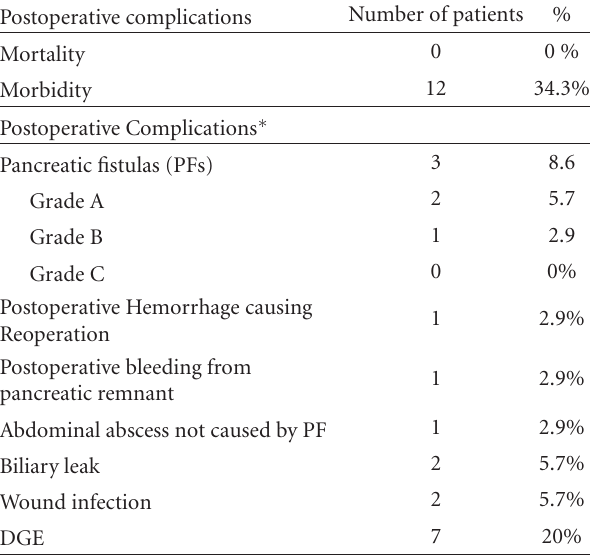
Table 1: Postoperative complications after the purse-string mat- tress suture